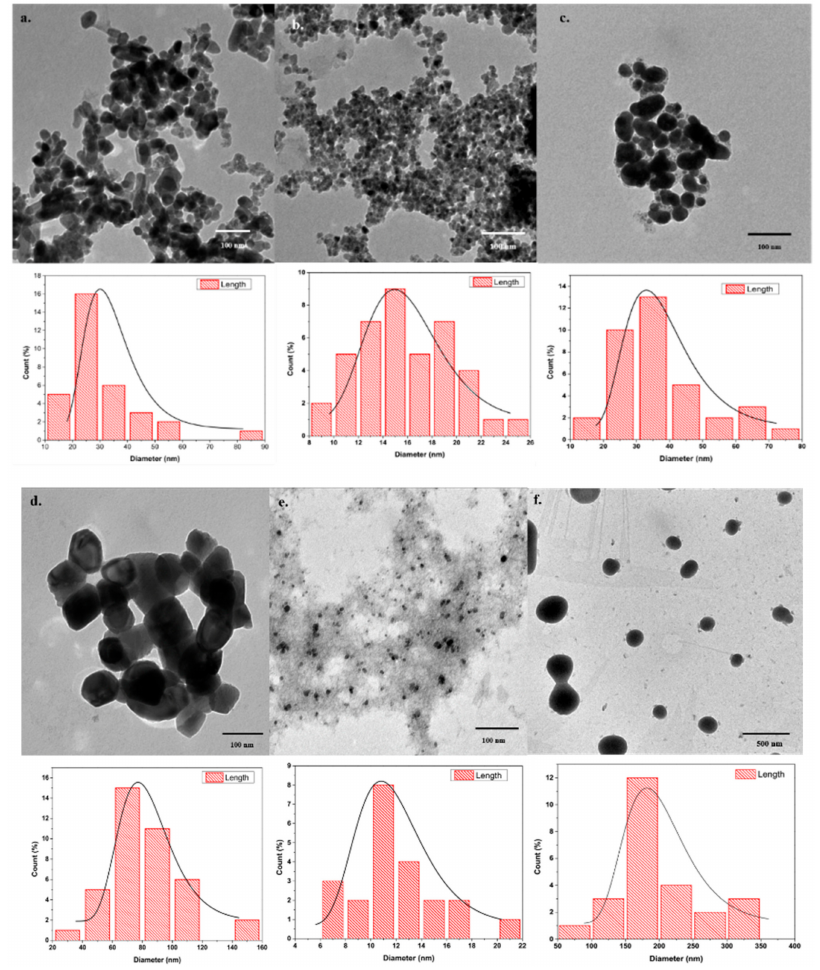
Figure 3. Transmission electron micrographs depicting the variation in the ZnO nanoparticle di- mensions for the reducing (RA) and capping/complexing (CA) agents. ( a ) Sodium hydroxide (RA), ( b ) Thiourea (RA), ( c ) Starch (RA), ( d ) Bovine serum albumin (CA), ( e ) Starch (CA), and ( f ) Cellulose